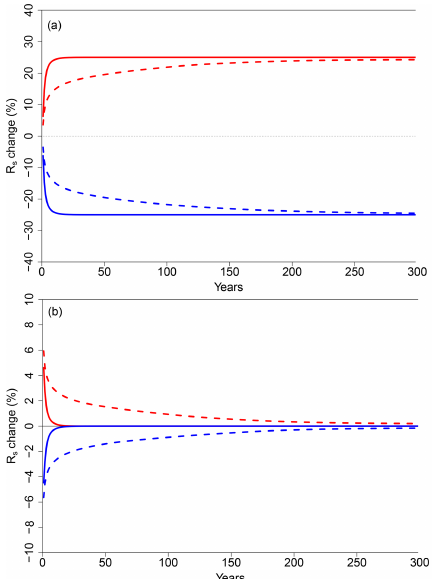
Figure 4. The percentage change (%) of total soil respiration be- tween the nominal and increased litter (red lines) and the nominal and decreased litter (blue lines) for (a) the litter quantity manipula- tion experiment and (b) the temperature manipulation experiment. Solid lines are for the biological and dashed lines for the chemical model. Only the first 300 years of the simulation are